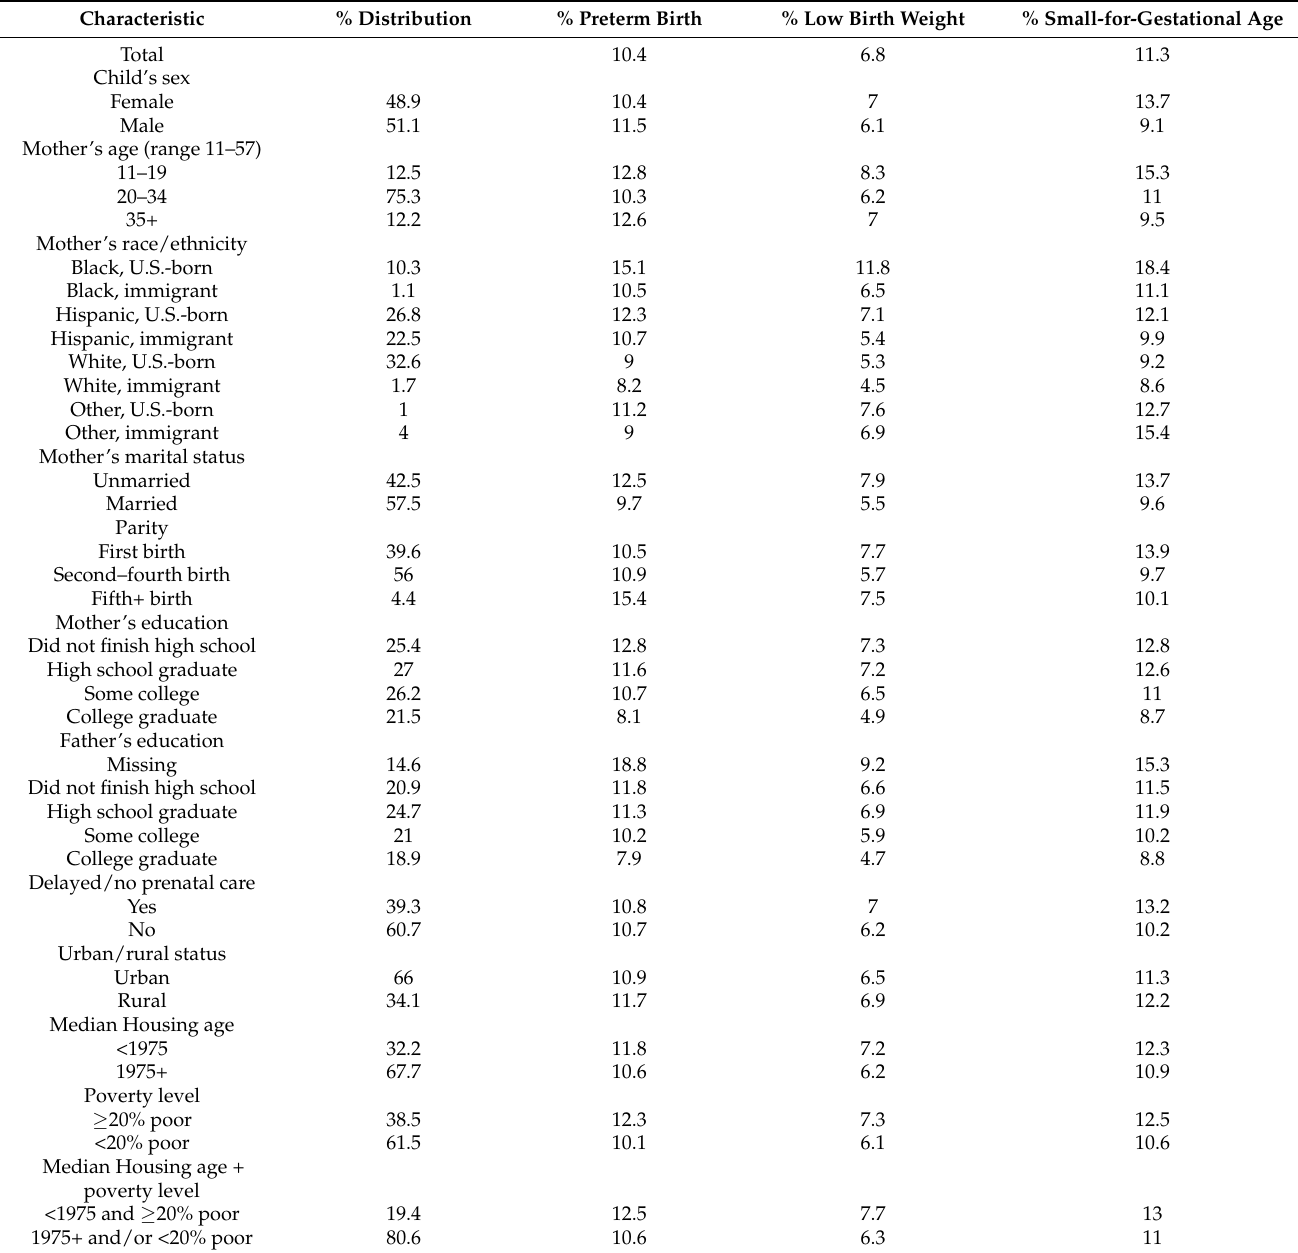
Table 1. Descriptive characteristics, 2009–2011 Texas natality files, n =